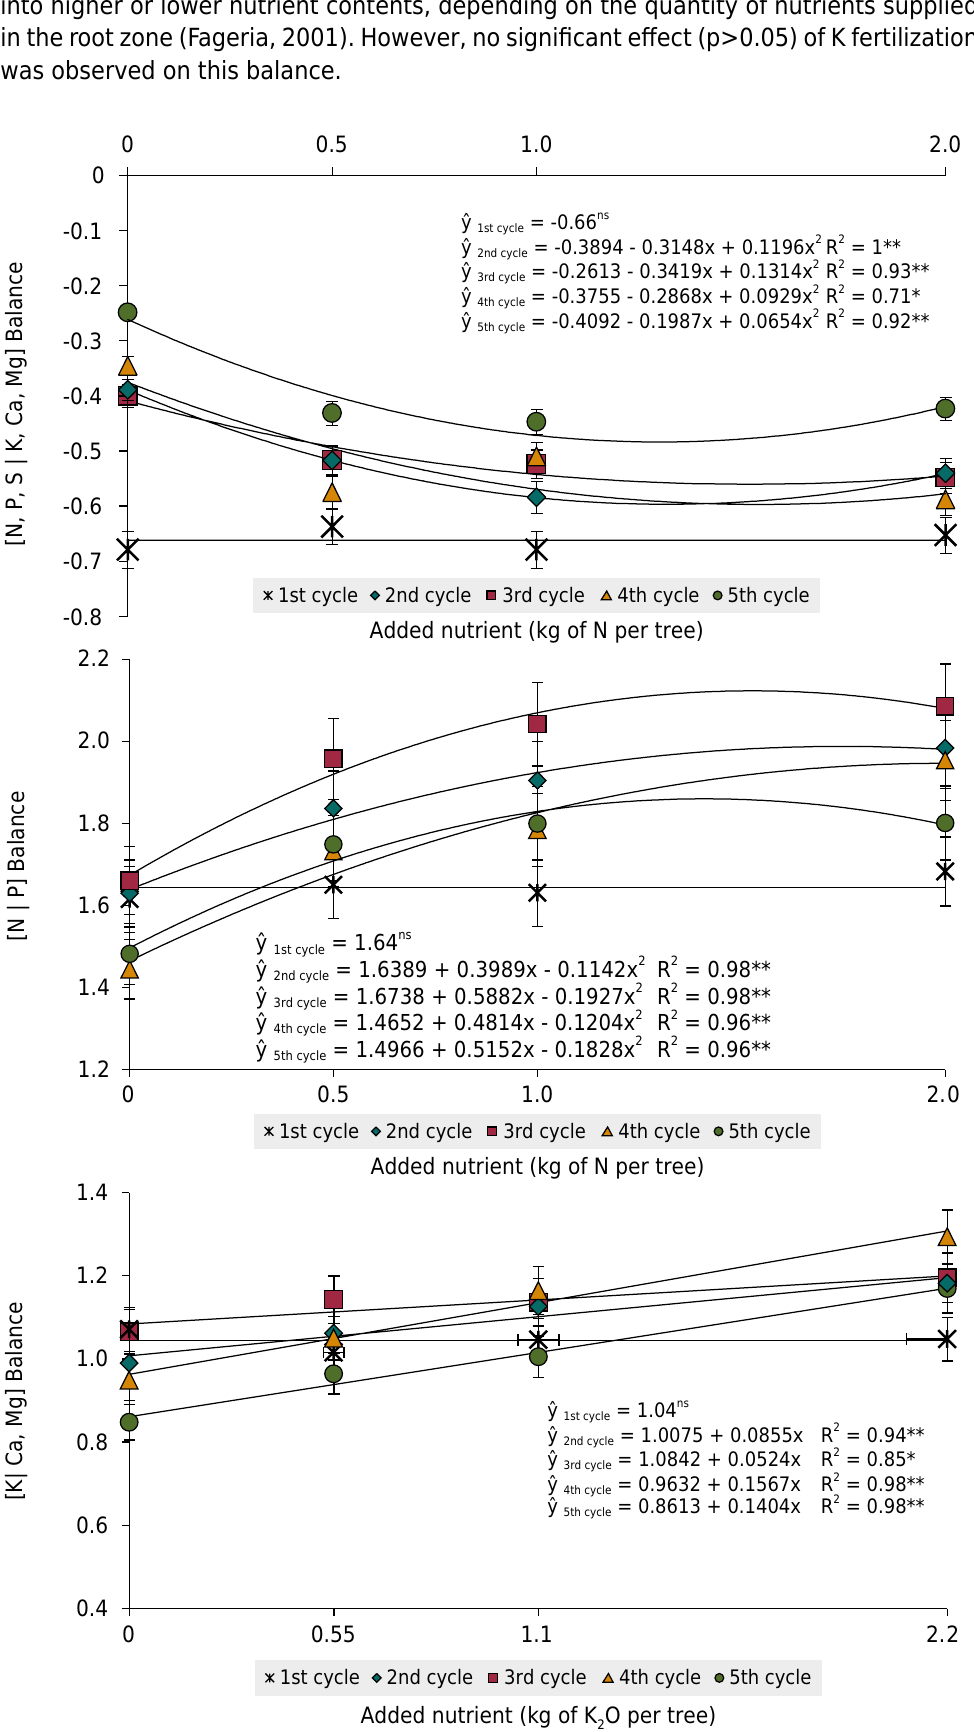
Figure 3. Leaf nutrient balances of ‘Paluma’ guava. Vertical bars at each point represent the standard error of the